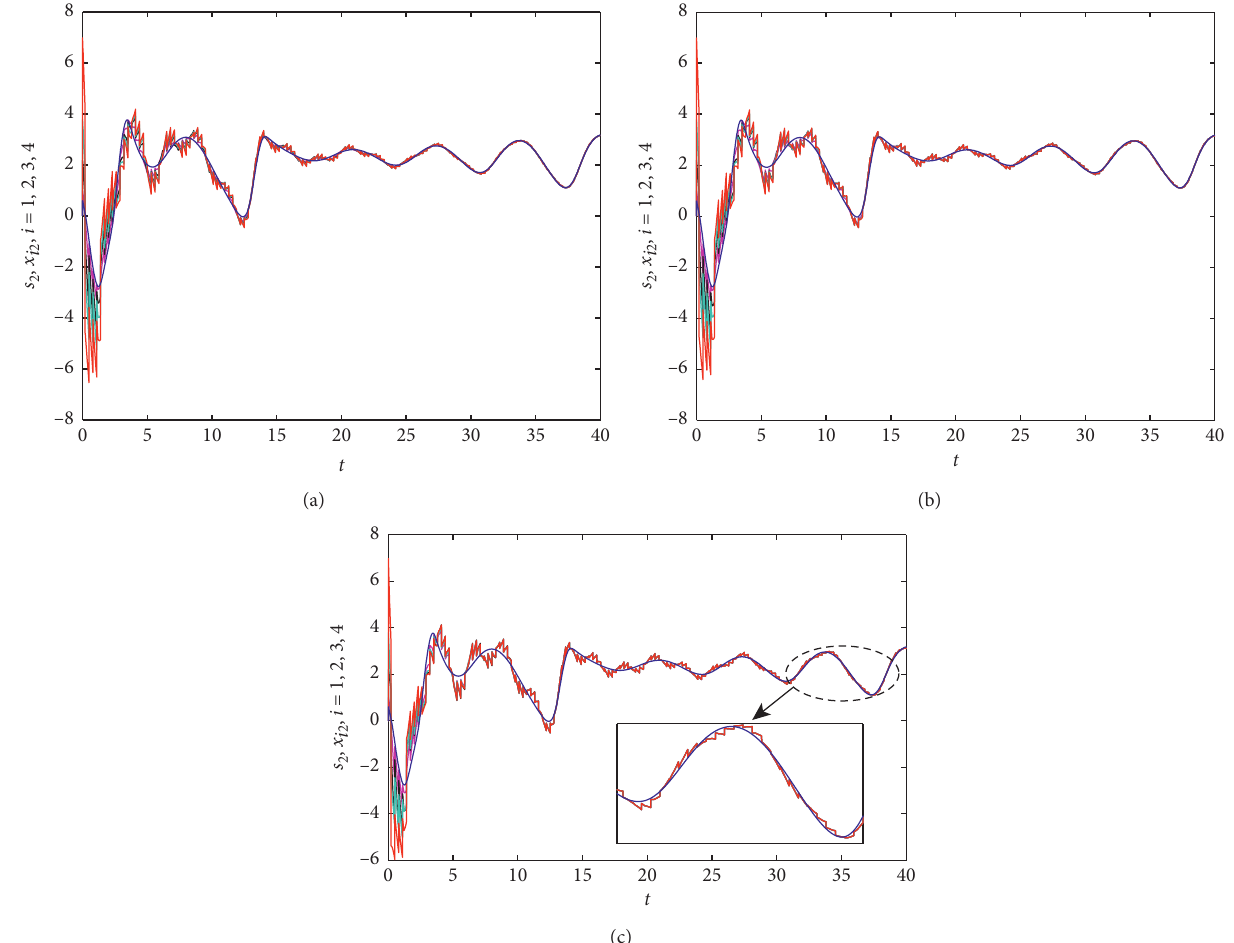
Figure 4: State trajectories with different coupling strength c for Example 1. (a) c � 0.001. (b) c � 0.2. (c) c � 1.